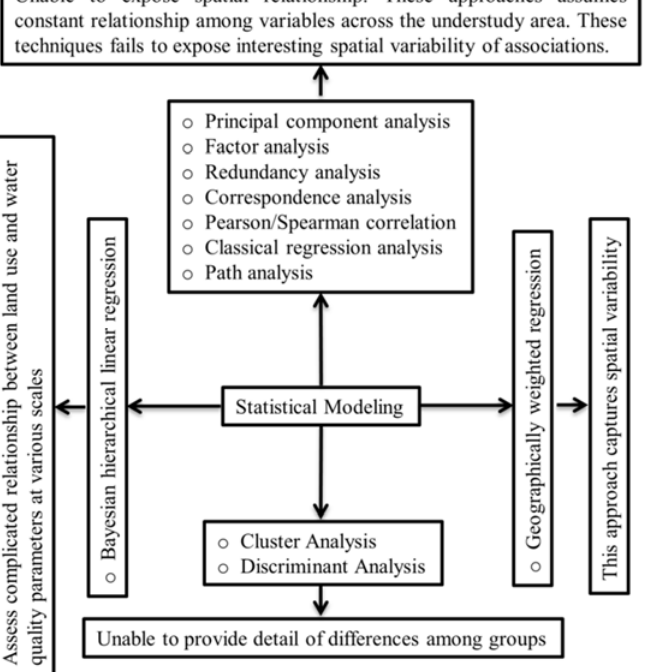
Fig. 5: Merits and demerits of statistical approaches